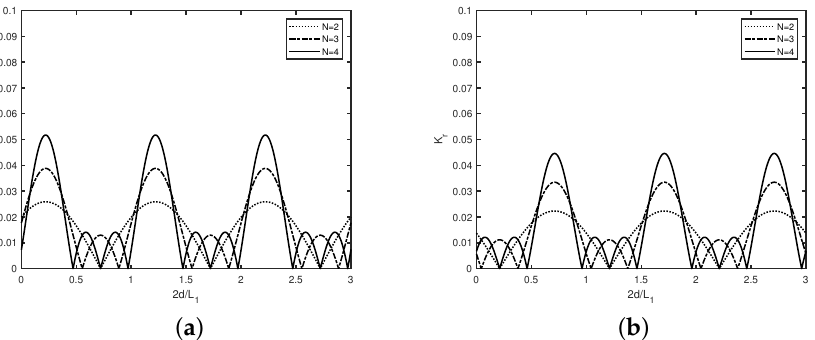
Figure 5. K r versus gap 2 d / L 1 for different number N of rectangular ( a ) trenches with width w / L 1 = 0.6; ( b ) breakwaters with width w / L 1 = 0.35 in the absence of the semi-infinite plate with L 1 = 40 π